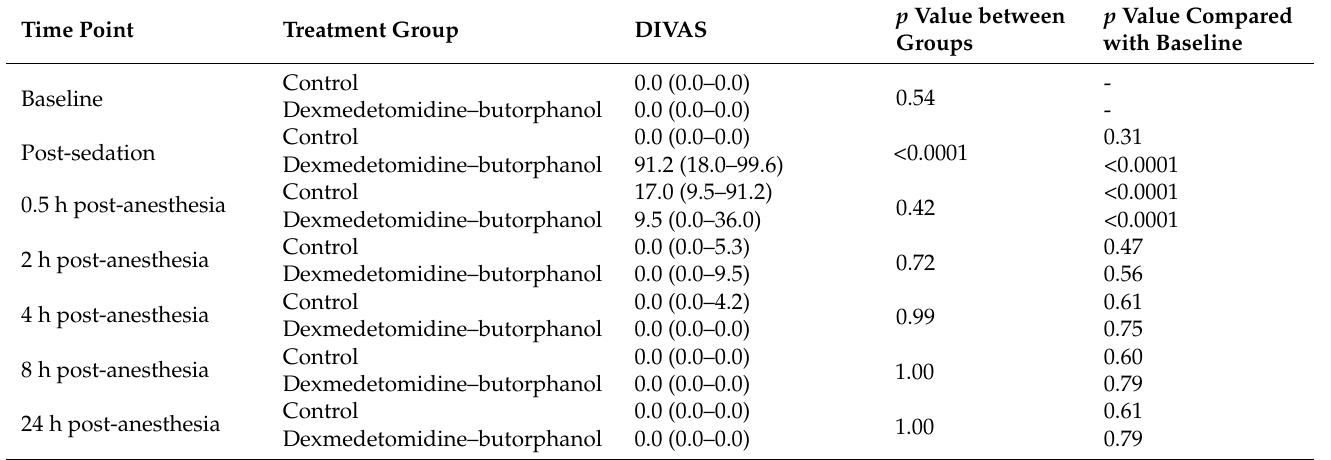
Table 1. Median (range) of dynamic interactive visual analog scale (DIVAS) scores in healthy cats before and after treatment with saline or dexmedetomidine and butorphanol, and general anesthesia with propofol and